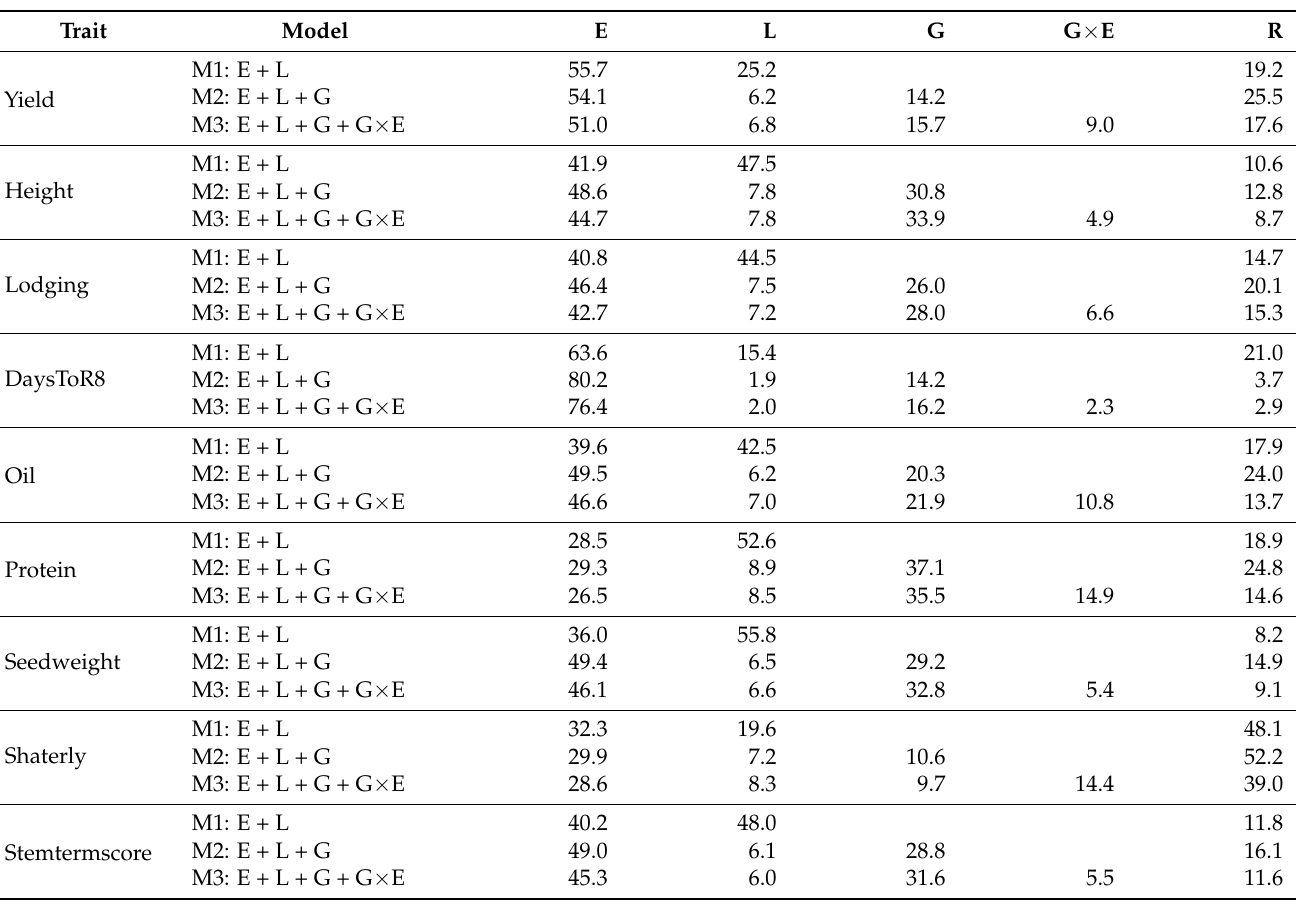
Table 1. Percentage of explained variability by each model term for all traits (9) using phenotypic and genomic data from the USDA soybean collection for 324 genotypes observed in 6 environments. Three models were considered, and these were constructed with the following components: E, main effect of environments; L, main effect of genotypes; G main effect of markers; and G × E for the interaction between genotypes and environments using marker data.